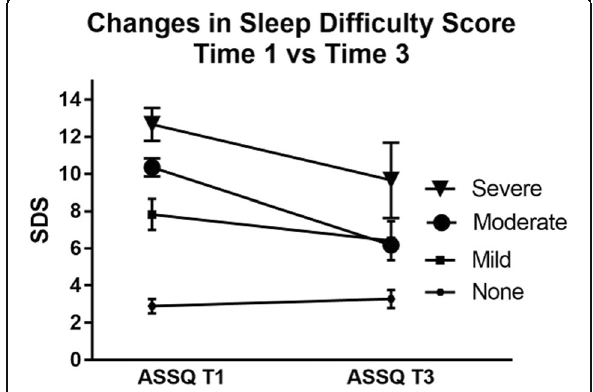
Fig. 2 Changes in sleep difficulty score for each clinical sleep problem category (none, n = 18; mild, n = 12; moderate, n = 11, and severe, n = 3) from time 1 (T1) at baseline to time 3 (T3) after